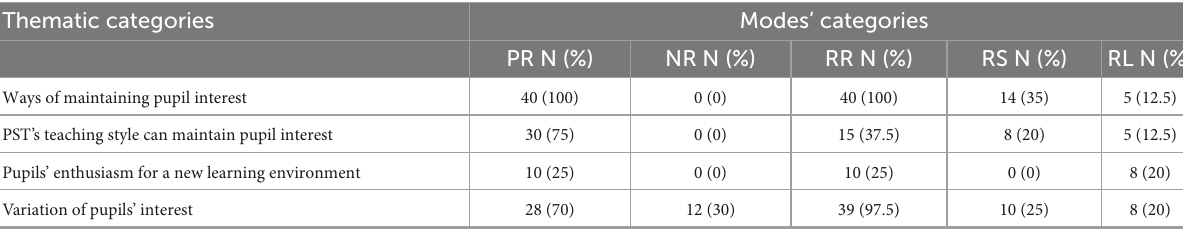
TABLE 2 Pre-service teachers’ modes of expressing pupil interest in the project-based learning (Pj-BL) approach. Thematic